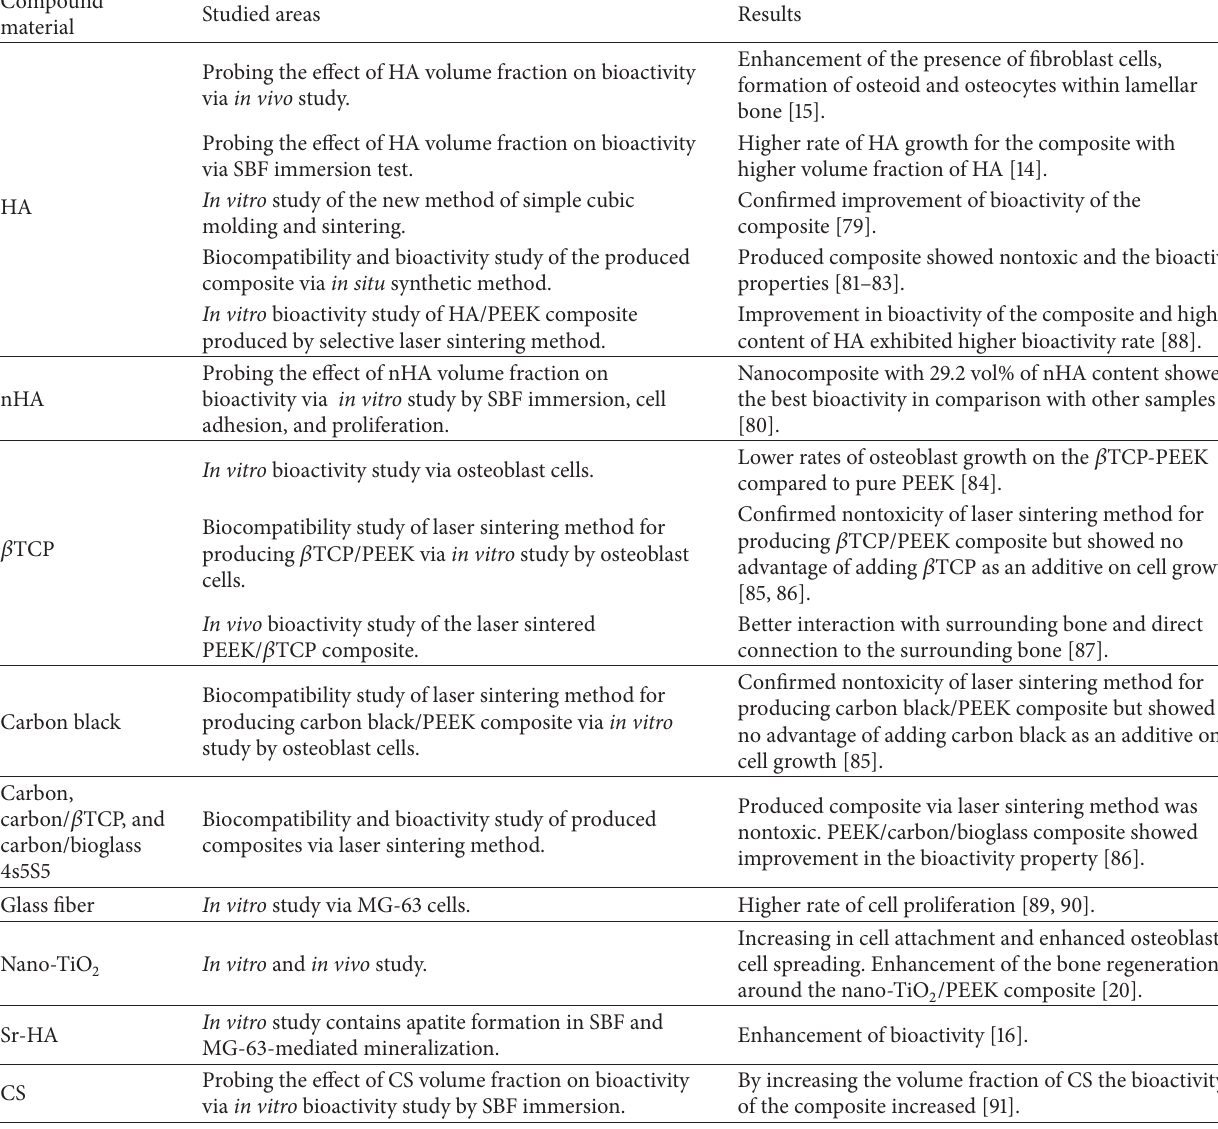
Table 4: Effect of the compound materials on the bioactivity of the PEEK